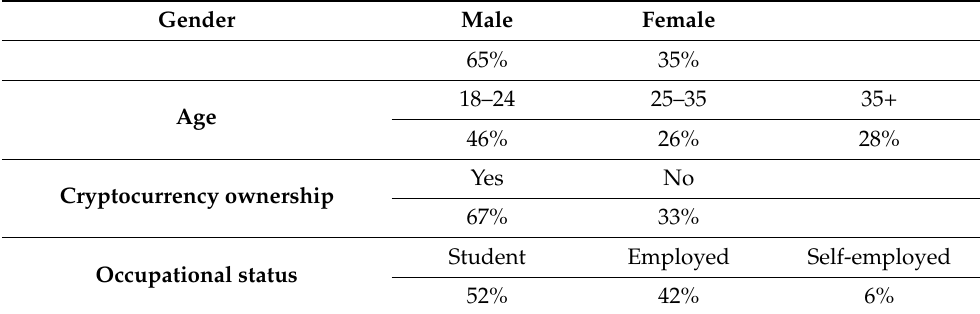
Table 1. Demographic data ( n =